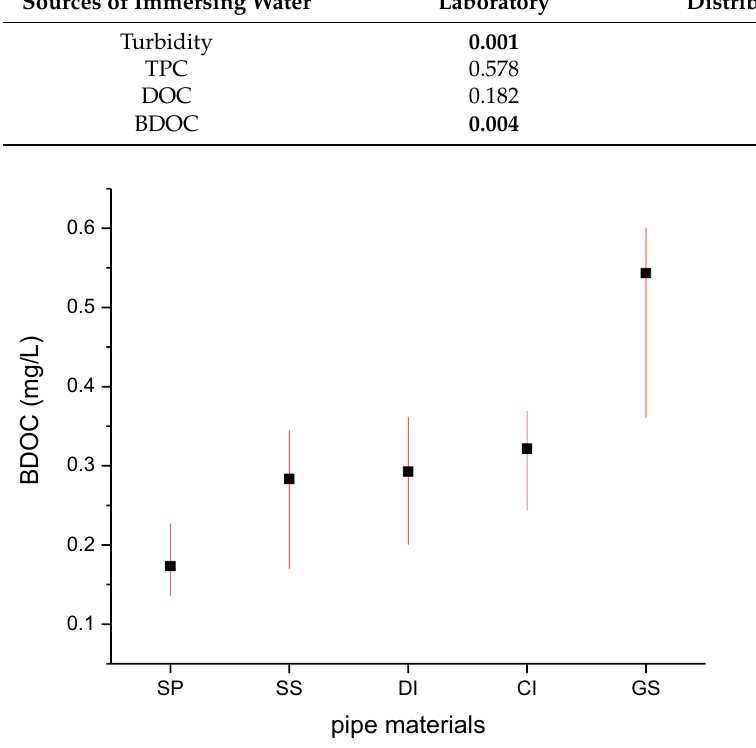
Figure 3. Multiple comparison test of the BDOC between different kinds of pipe material using water collected from the distribution system node (the type of critical value to use for the multiple comparisons is Kruskal–Wallis test, and the significance level is 0.05).